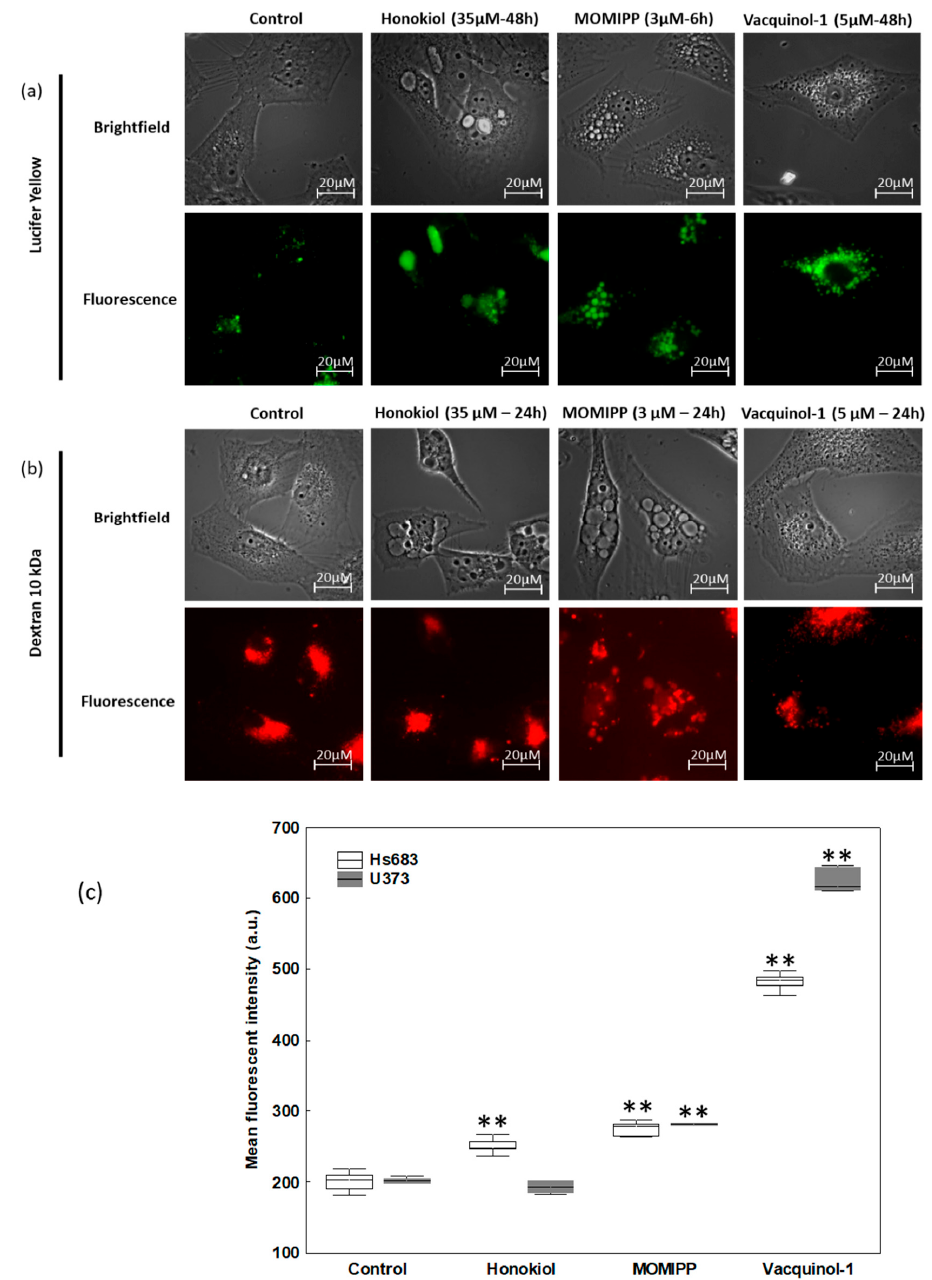
Figure 7. Lucifer yellow and fluorescent 10 kDa dextran uptake by U373 cells treated with honokiol, MOMIPP, or vacquinol-1. ( a ) Illustration of Lucifer yellow staining (100 µg/mL during the whole treatment period). Exposure time is the same for all conditions. The experiment has been conducted three times in duplicate. ( b ) Illustration of fluorescent 10 kDa dextran uptake. Again, cells were treated with each compound in presence of 10 kDa Texas-Red labeled dextran (125 µg/mL) for 24 h. Some vacuoles are positive with MOMIPP and vacquinol-1 but none with honokiol. Exposure time has been adjusted for each condition (550 ms for the control, 490 ms for honokiol, 650 ms for MOMIPP and 160 ms for vacquinol-1). The experiment has been conducted twice in duplicate. ( c ) Quantitative dextran 10 kDa uptake by U373 and HS683 determined by flow cytometry after 24 h and 30 h, respectively. Data are expressed as box plots: line, median; boxes, percentiles 25–75; and whiskers, non-outlier ranges of six experiments. Statistical comparisons with untreated cells are based on Mann–Whitney tests according to conventional thresholds: p < 0.05 (*), p < 0.01 (**) and p < 0.001